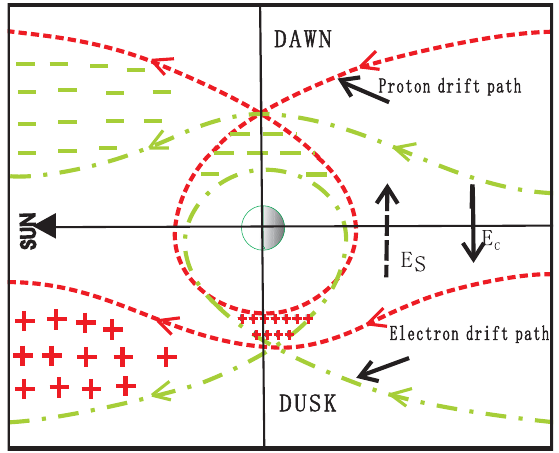
Fig. 1. Drift trajectories of ions from different positions in the equa- torial plane.